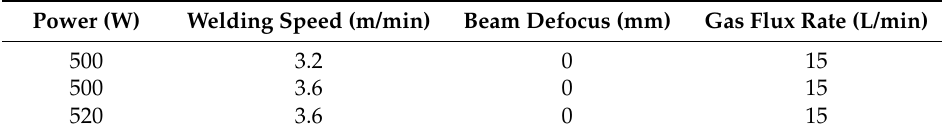
Table 2. Welding experiment and simulation parameters.